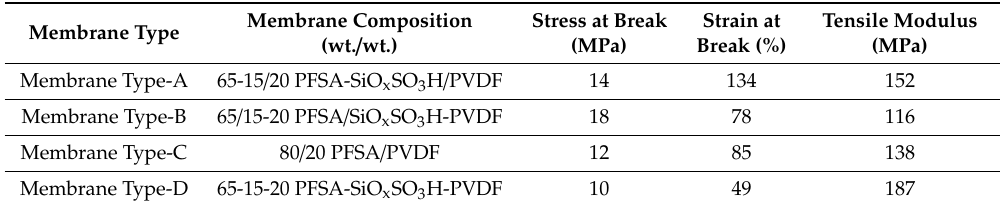
Figure 7. Stress-strain curves for Membrane Types A-D at 22 °C and 20% RH. Table 5. A summary of tensile characteristics of the four composite membranes in air at 22 °C and ≈ 20% RH.